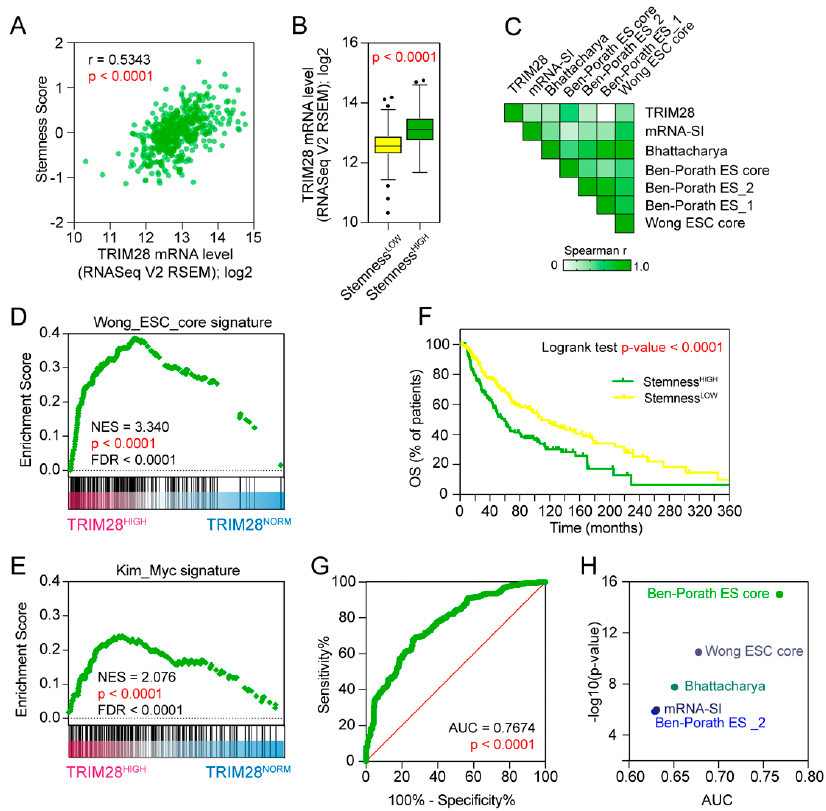
Figure 2. TRIM28 high expressing melanomas are dedifferentiated tumors characterized by high stemness scores. ( A ) Spearman correlation of the TRIM28 expression with the Stemness Score [16]